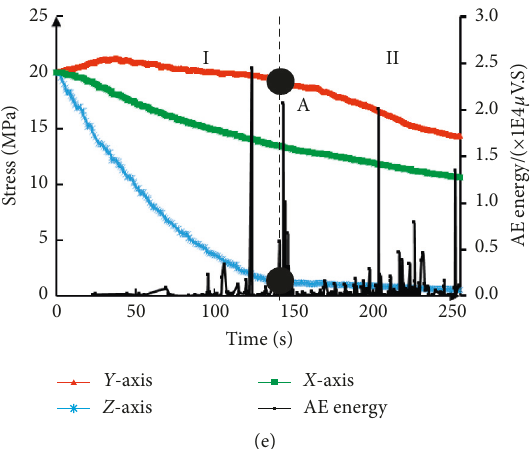
Figure 2: Triaxial stress-time curves of coal samples and acoustic emission-time curves. (a) Initial isobaric pressure (RURLR of 0.6). (b) High initial unloading lateral stress (RURLR of 0.6). (c) High initial stress of loading lateral (RURLR of 0.6) (d) High initial stress of fixing lateral (RURLR of 0.8). (e) High RURLR